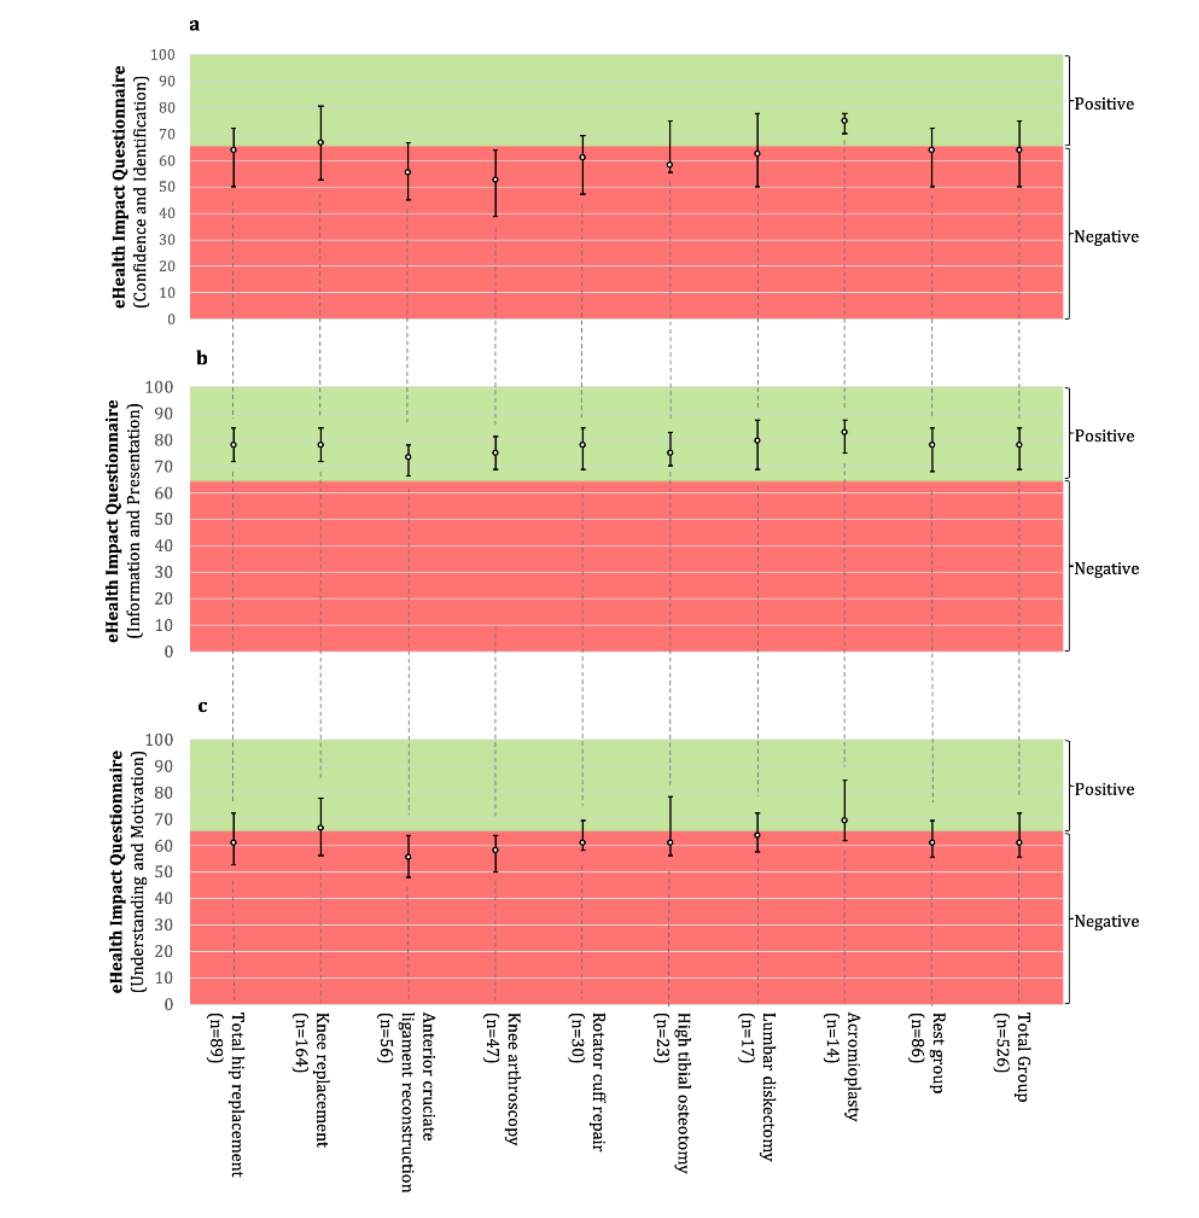
Figure 4. Attitude toward the app: (a) Confidence and Identification, (b) Information and Presentation, and (c) Understanding and